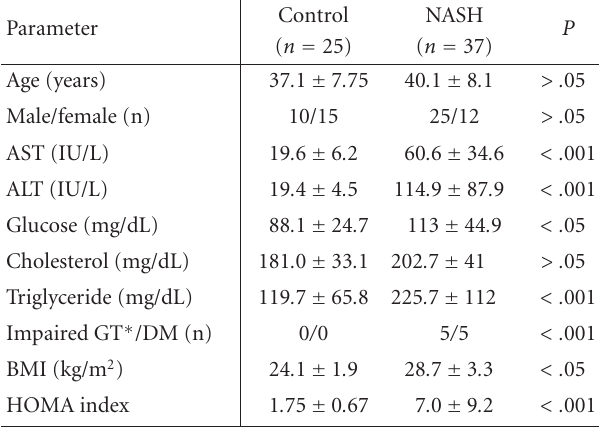
Table 1: Demographic and clinical data in control and NASH